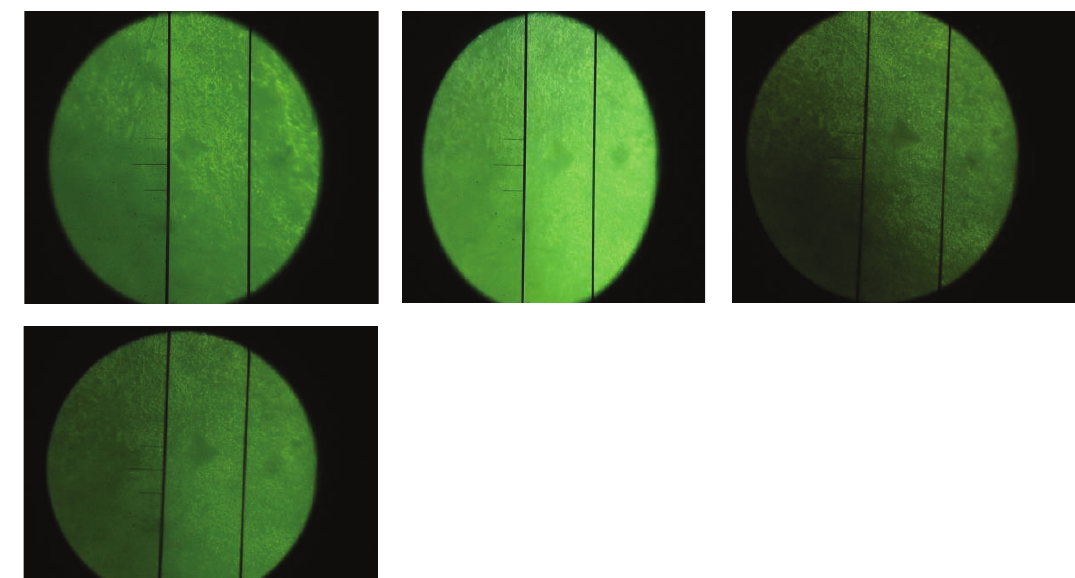
Figure 1: Indentation of the Knoop indenter as viewed under a microhardness